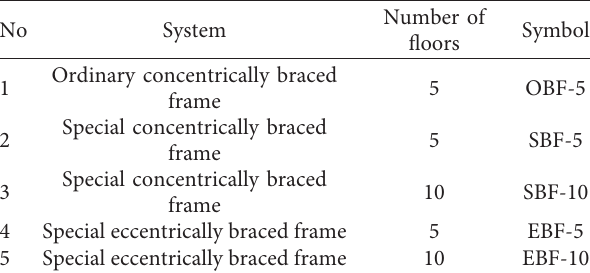
Figure 7: Plan of structures and load-bearing direction of floors. Table 4: Naming the frames under study.